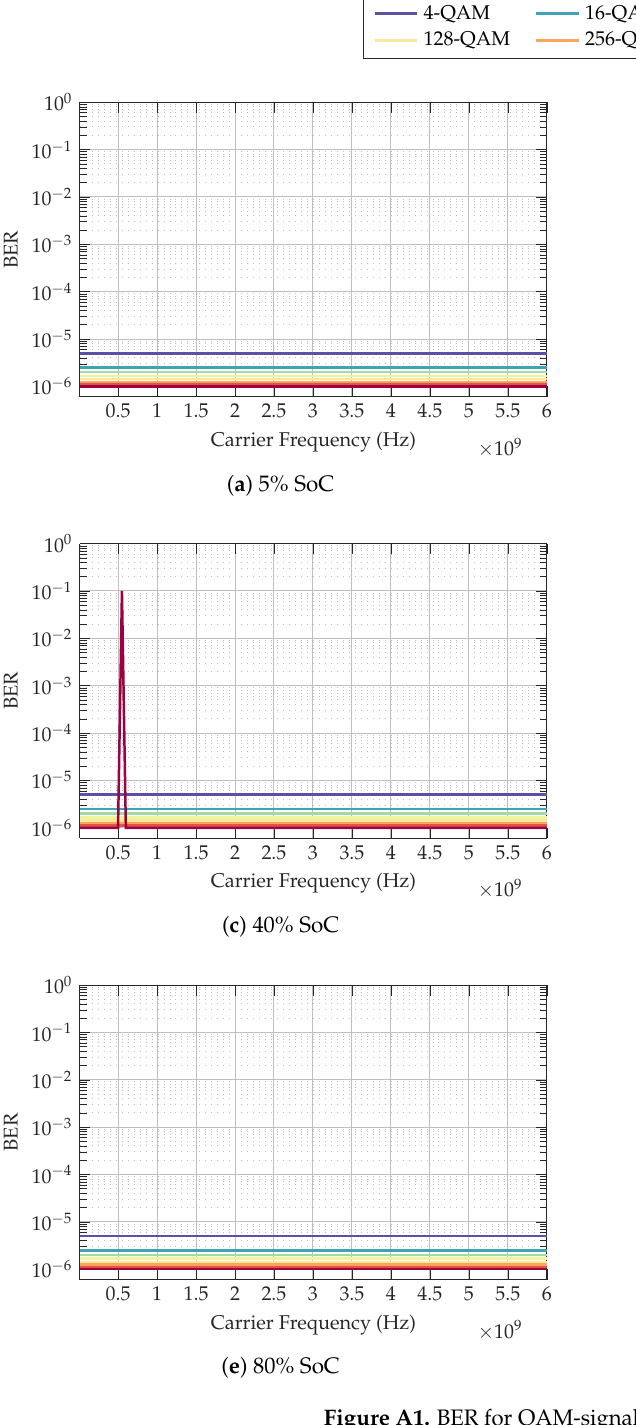
Figure A1. BER for QAM-signals transmitted with a peak output power of cell at various SoC. Each QAM order is represented in a different colour. Each order of QAM has a different minimum BER since the number of transmitted symbols is kept constant, rather than the number of transmitted